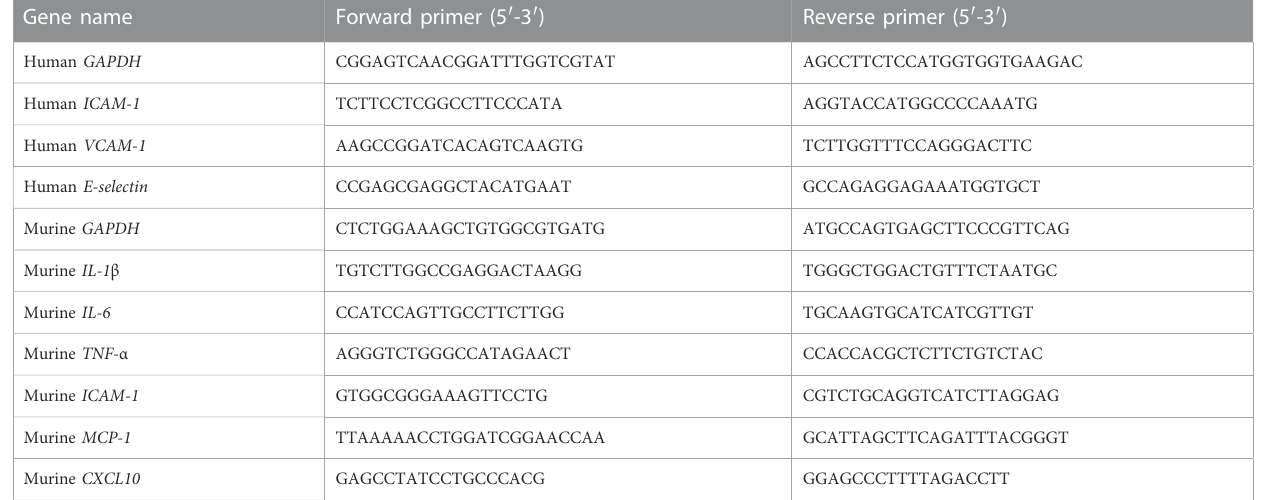
TABLE 1 Primer sequences used in the